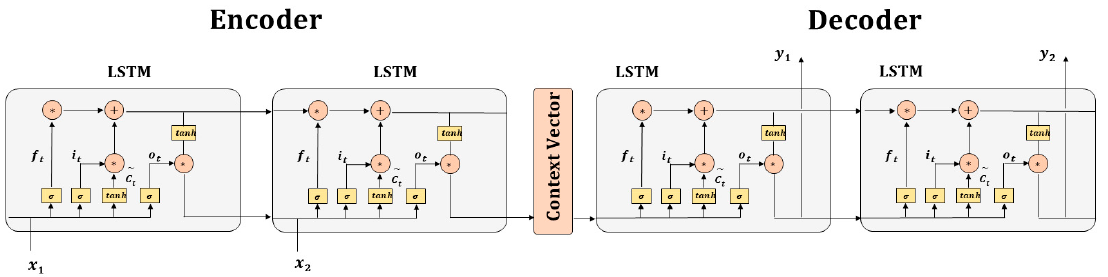
Figure 3. The architecture of the Seq2Seq model.